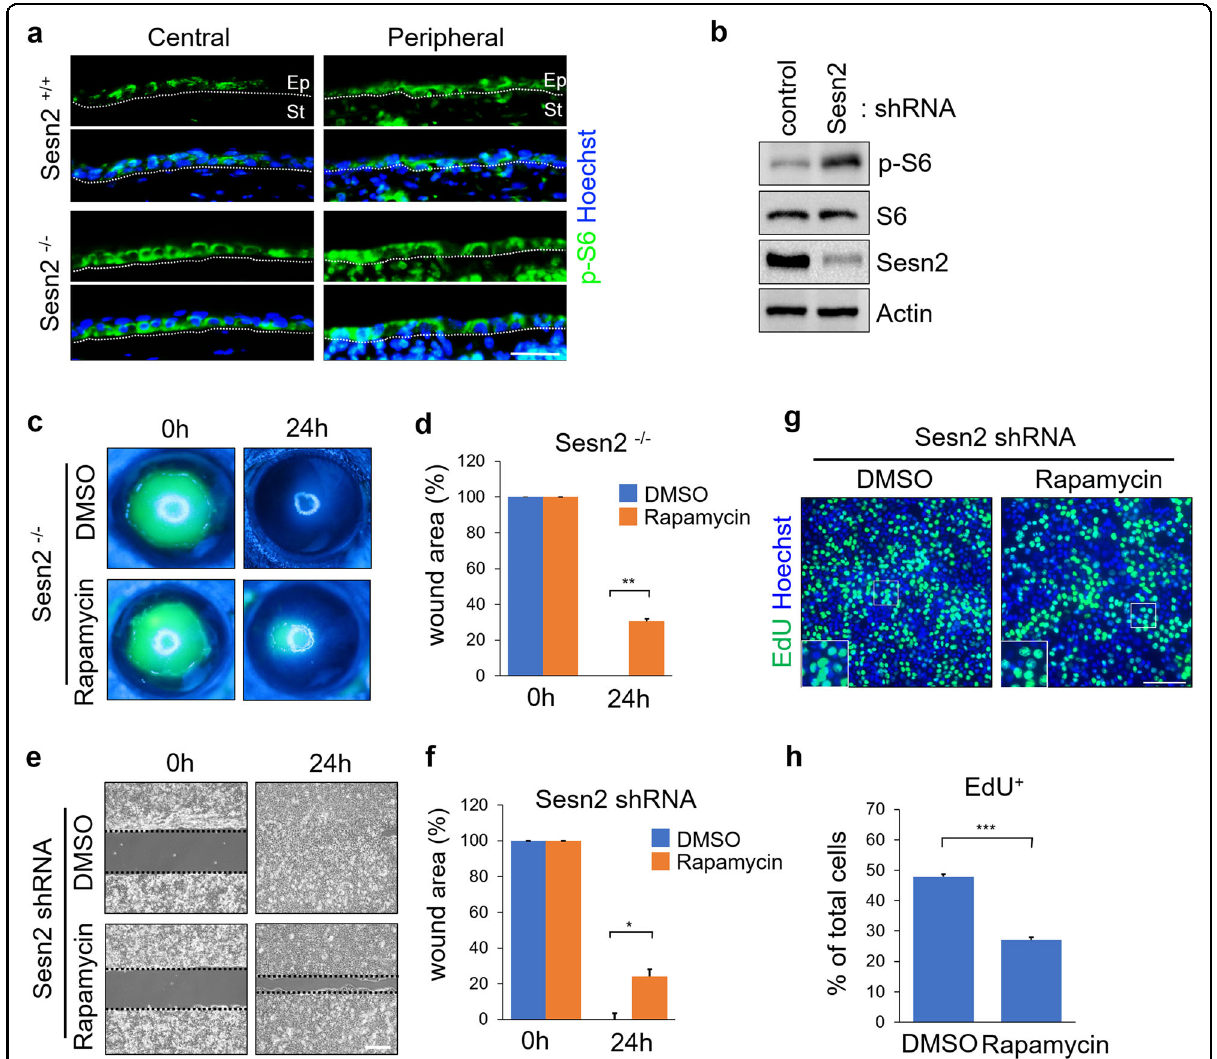
using an anti-phospho-S6 antibody. Phospho-S6 expression was increased in the corneal epithelium of Sesn2 − / − mice compared to that in the corneal epithelium of Sesn2 + / + mice. Dotted lines indicate the basement membrane. b hCET cells expressing Sesn2 shRNA or control shRNA were subjected to western blotting with phospho-S6, S6, Sesn2, and actin antibodies. c In vivo corneal epithelial wound healing in Sesn2 − / − mice